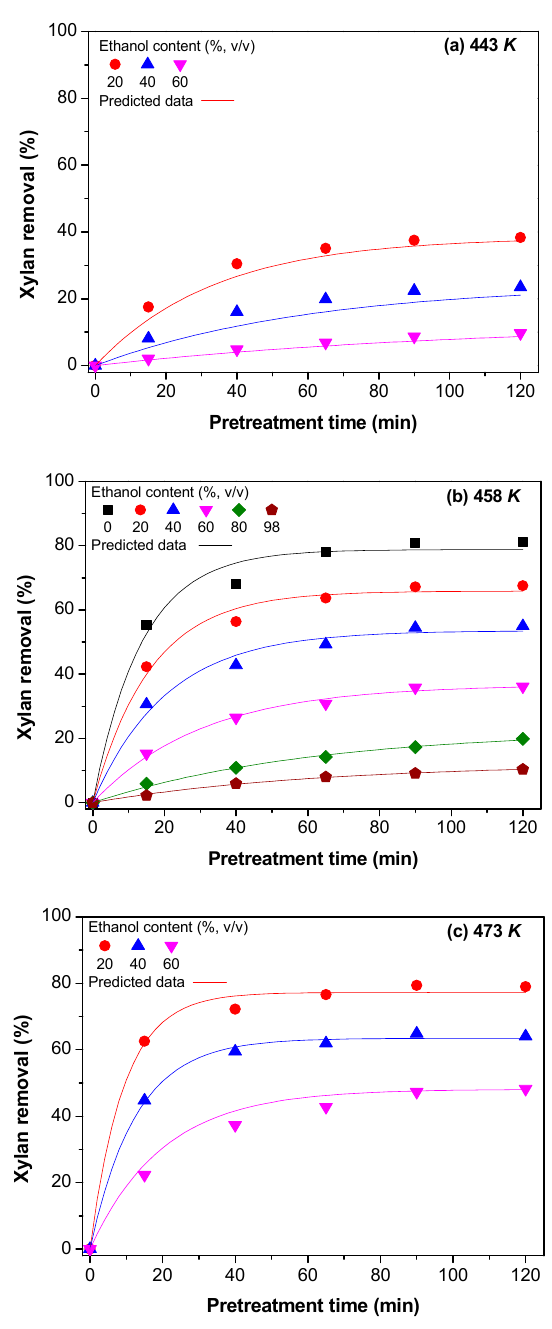
Figure 1. Measured and predicted xylan removal at EACO pretreatment temperature of ( a ) 443, ( b ) 458 and ( c ) 473 K with different ethanol content (%, v/v) in pretreatment liquor.